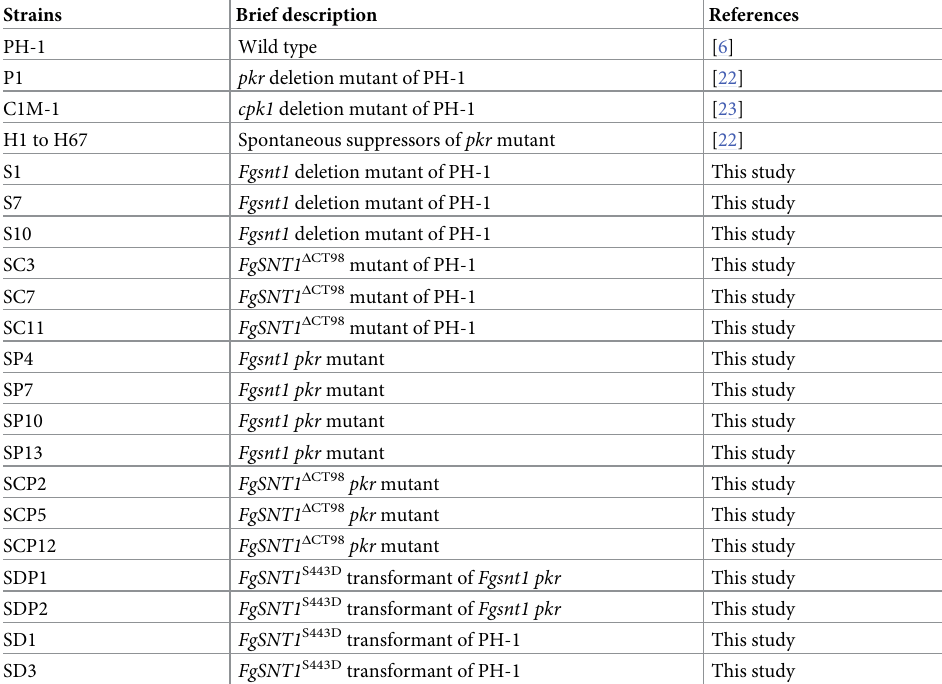
Table 2. The wild-type and mutant strains of F . graminearum used in this study.